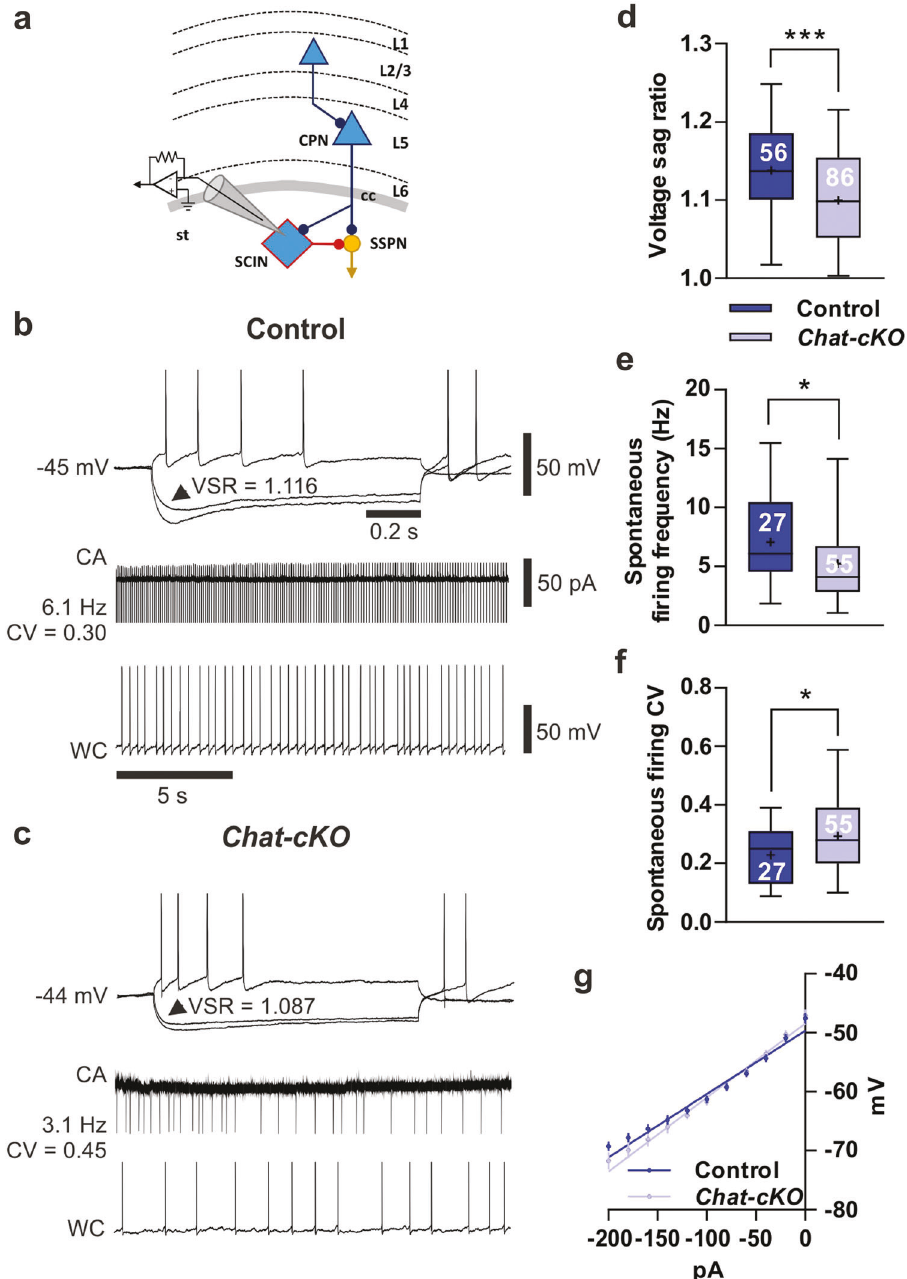
Fig. 4 Altered electrophysiological properties of SCINs in Chat-cKO mice. a Simpli fi ed scheme of the corticostriatal circuitry with the recording patch-clamp pipette placed on a SCIN. TSHZ3-expressing neurons are blue (L1-6, cortical layers 1 – 6; cc, corpus callosum; st, striatum). b Sample traces obtained from a representative control SCIN: note the prominent voltage sag in response to − 200 and − 120 pA hyperpolarizing currents, and the AP fi ring during a + 100 pA depolarizing current (1st line), as well as the sustained and regular fi ring in cell- attached (CA) and whole-cell (WC) con fi guration (2nd and 3rd line, respectively). c Sample traces obtained from a representative Chat-cKO SCIN: compared to ( b ), note the smaller voltage sag as well as the less regular, lower frequency spontaneous fi ring. b , c The values of voltage sag ratio (VSR) of the response to − 120 pA current injection (arrowhead), as well as the frequency and coef fi cient of variation (CV) of spontaneous fi ring of these samples, are reported; spikes have been cut; calibration bars are the same in ( b ) and ( c ). Compared to control, SCINs from Chat-cKO mice show a signi fi cant reduction of mean voltage sag ratio ( d) and frequency of spontaneous discharge ( e ), while the CV of their inter-AP interval is increased ( f ) meaning that their spontaneous fi ring is more irregular. The number of recorded SCINs in ( d ) – ( f ) is reported in the graphs. g Current – voltage relationship obtained from 51 control and 62 Chat-cKO SCINs, and the linear best fi t to calculate input resistance (see Results). * P < 0.05, *** P < 0.001, Student ’ s t test; data in ( d – f ) are expressed as box and whiskers (25th – 75th and 5th – 95th percentiles, respectively), where bar = median and cross = mean; data in ( g ) are expressed as means ± SEM.